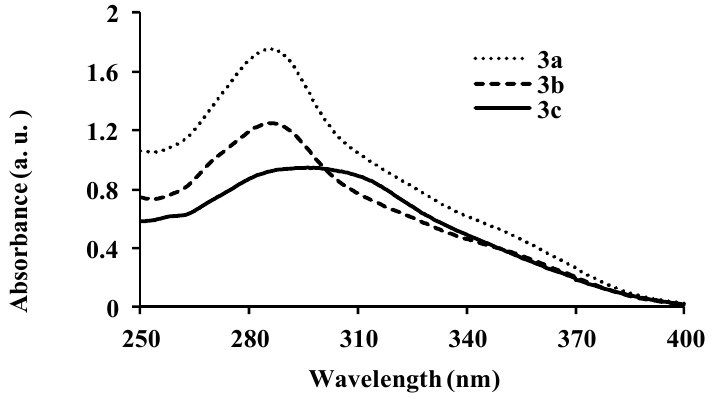
Figure 3. UV-Vis spectra of 4a – c in CHCl